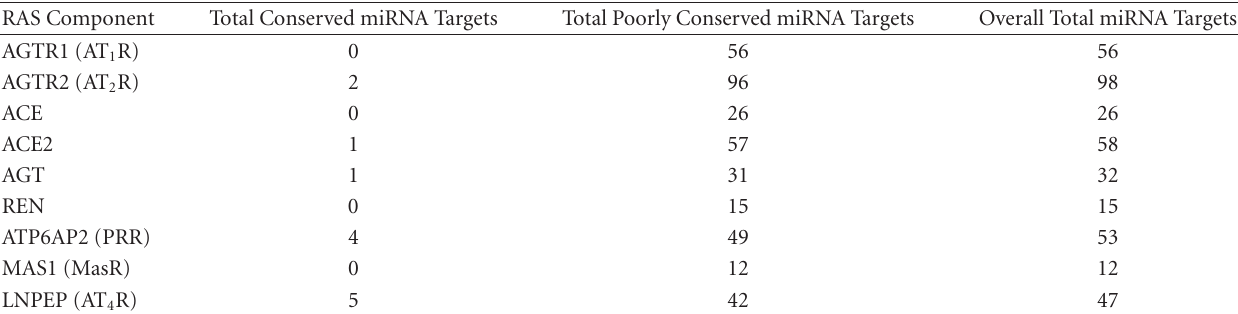
Table 1: TargetScan ∗ algorithm-predicted RAS putative miRNA/mRNA target